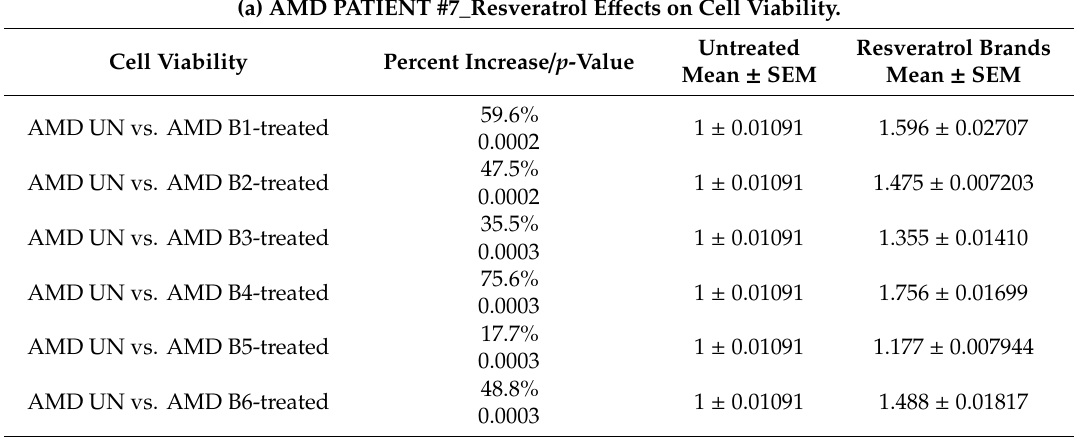
Figure 8. E ff ects of resveratrol formulations on cell viability ( A ) and ROS levels ( B ) in AMD patient #7.